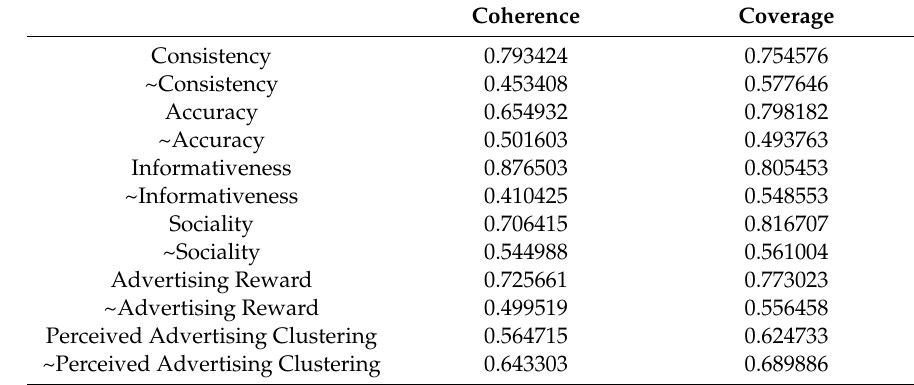
Table 6. Necessity analysis results (~indicates that the antecedent variable does not exist or the level is